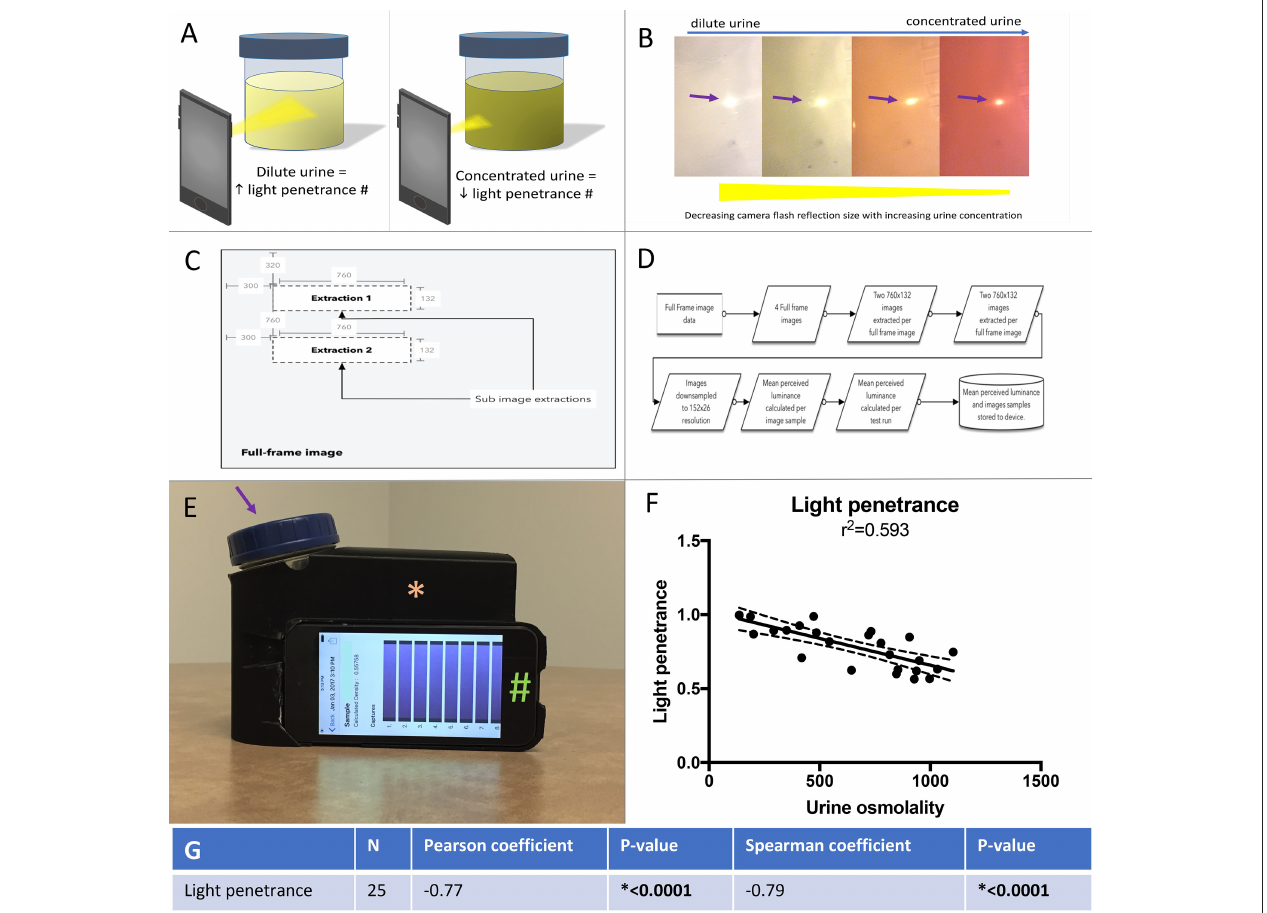
FIGURE 2 | (A) Left panel, a dilute urine sample results in in increased light penetrance and increased diameter of camera flash. The camera flash is being used to illustrate light penetrance, but was not directly measured for the mobile technology application. Right panel, a concentrated urine sample results in decreased light penetrance and decreased diameter of camera flash. (B) The correlation between urine concentration, camera flash diameter (arrow) and light penetrance is demonstrated. (C) Full-frame with sub-image extraction. (D) Capture and analysis workflow. (E) An example of the urine collection container (arrow) and ipod (#) in the 3D printed adaptor (asterisk), (to standardize for variable room light levels and distance from camera to urine sample). (F) Linear regression with best fit (solid line) and 95% confidence intervals (dashed lines) for urine osmolality vs. light penetrance as measured by the mobile technology application. (G) Spearman and Pearson’s correlations and associated p values for correlation between light penetrance and urine